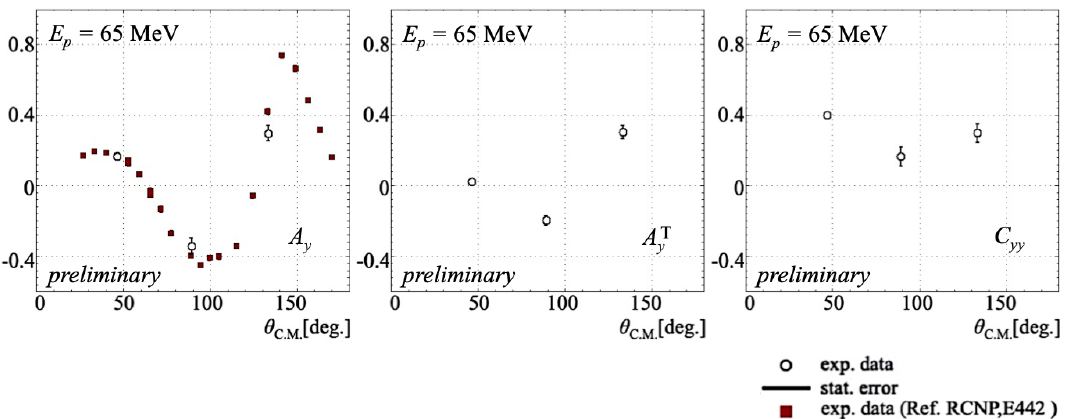
Figure 2: Results of the proton analyzing power A the spin correlation coefficient C